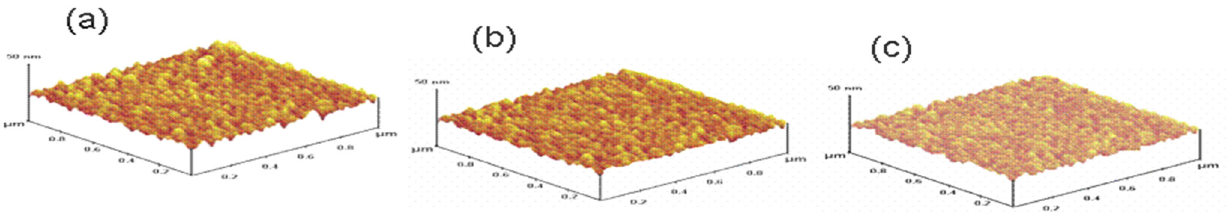
Figure 6. AFM of ( a ) In 2 O 3 and ( b ) (In 0.94 Gd 0.06 ) 2 O 3 thin films and ( c ) (In 0.90 Gd 0.10 ) 2 O 3 thin films.